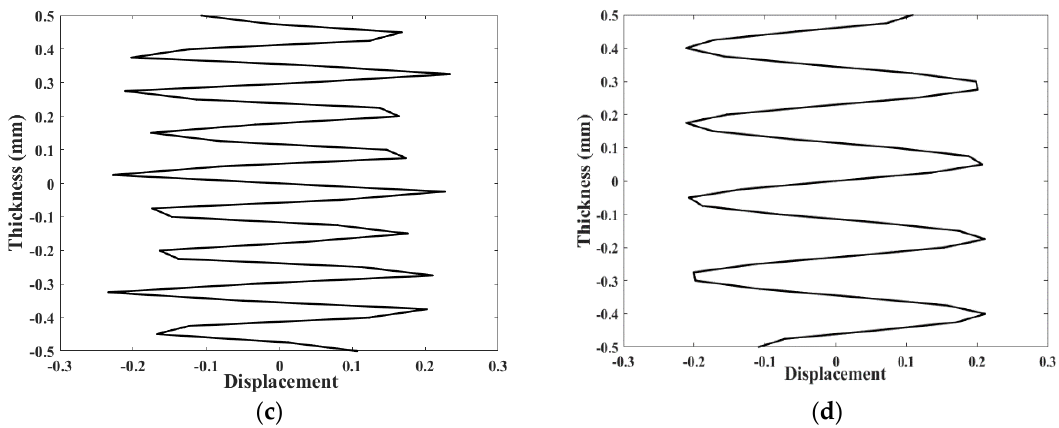
Figure 12. The mode shapes of mode 10 and 15: ( a ) the fundamental mode of mode pair 10; ( b ) the second harmonic mode of mode pair 10; ( c ) the fundamental mode of mode pair 15; and ( d ) the second harmonic mode of mode pair 15.